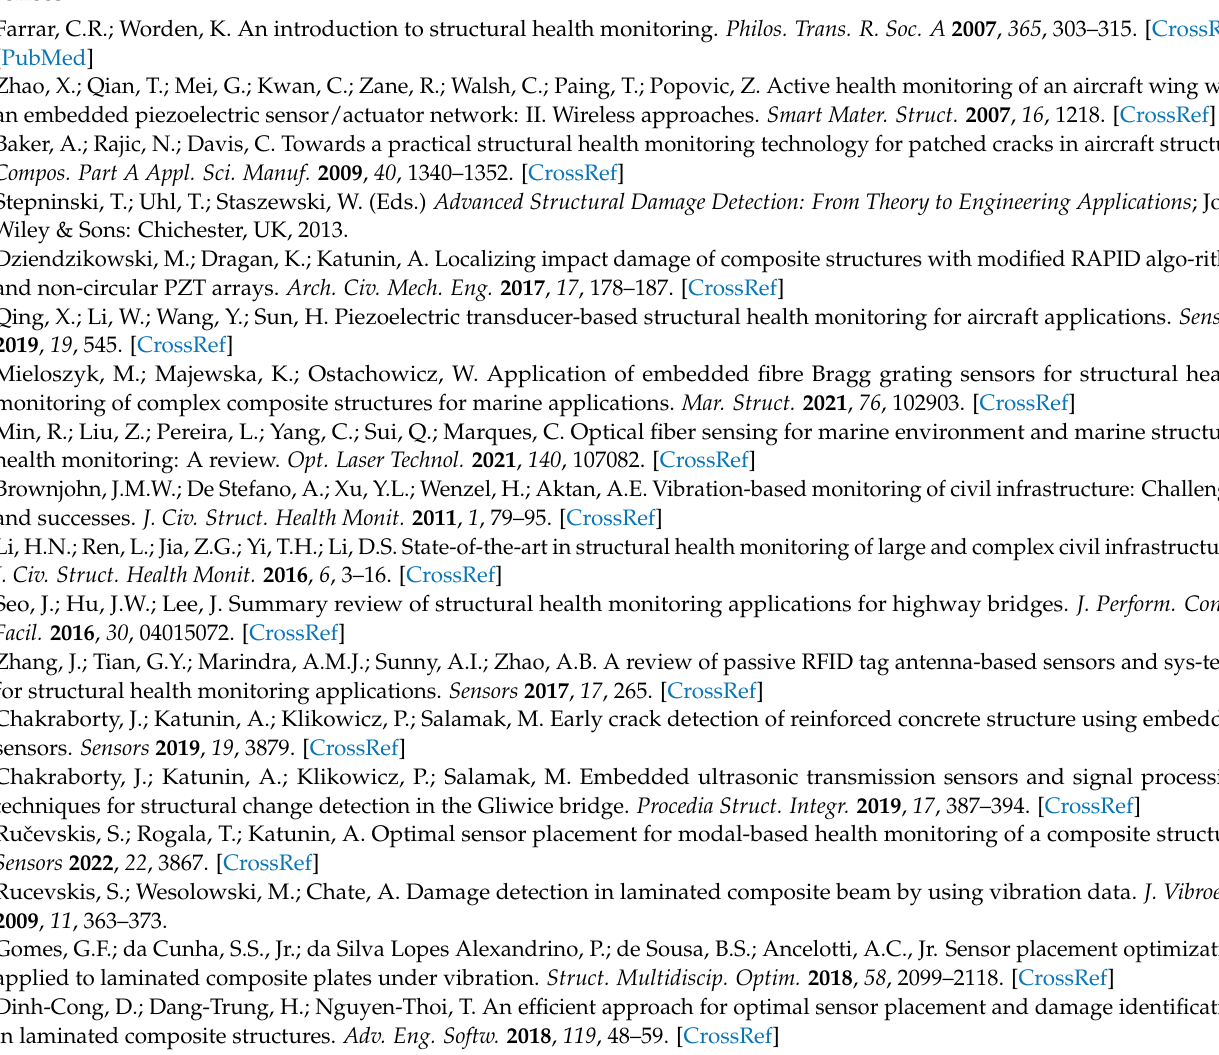
Figure A7. Objective function evaluation plot for the k-NN classifier trained for the first mode of the second learning scheme (higher precision of localization).